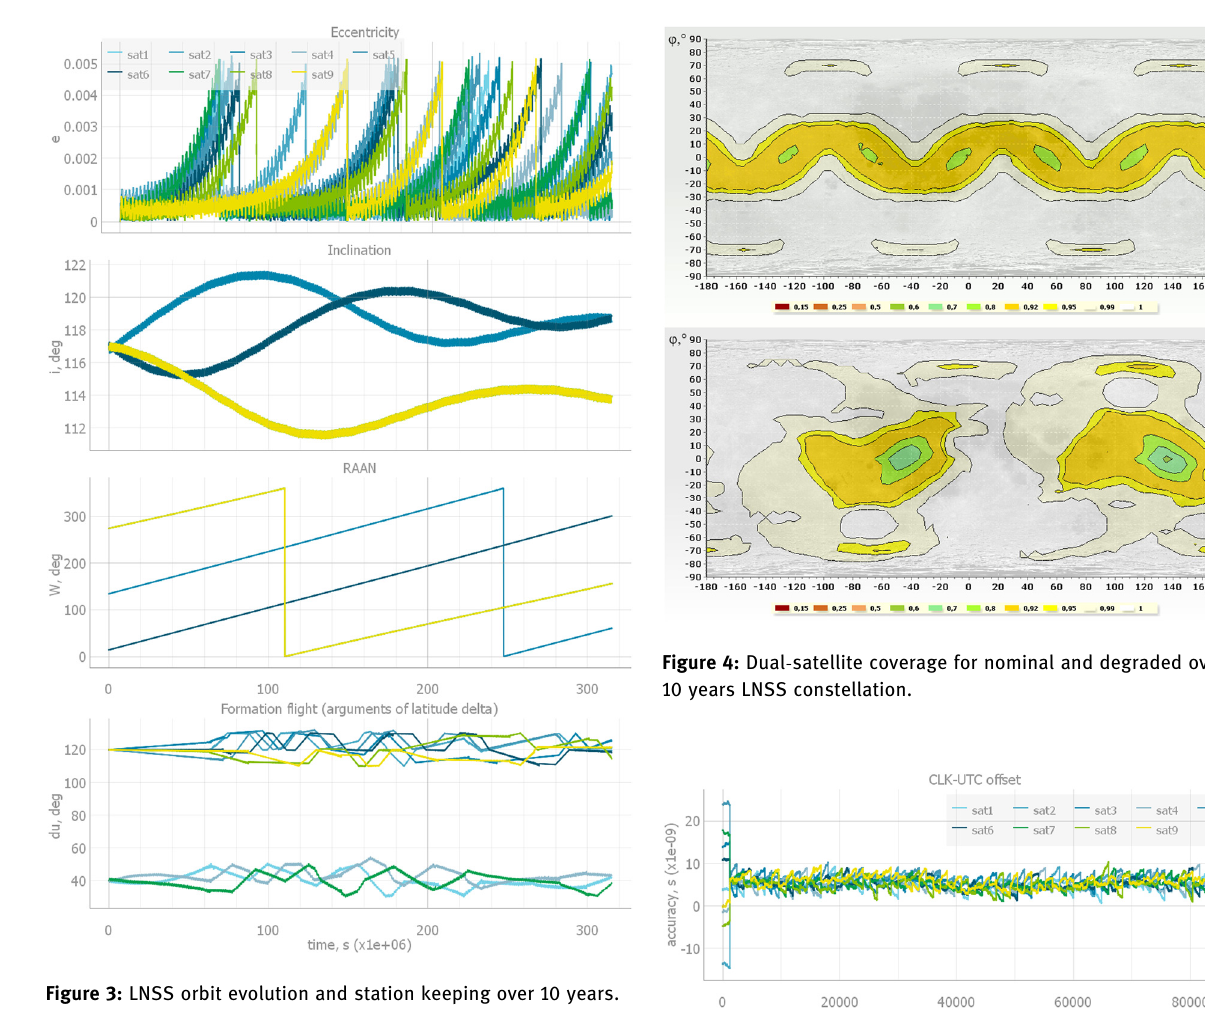
Figure 3: LNSS orbit evolution and station keeping over 10 years.